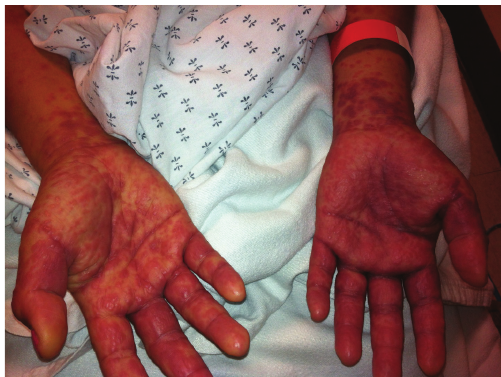
Figure 1: Anterior neck and upper chest: discrete and coalescing, slightly blanching, planar plaques.